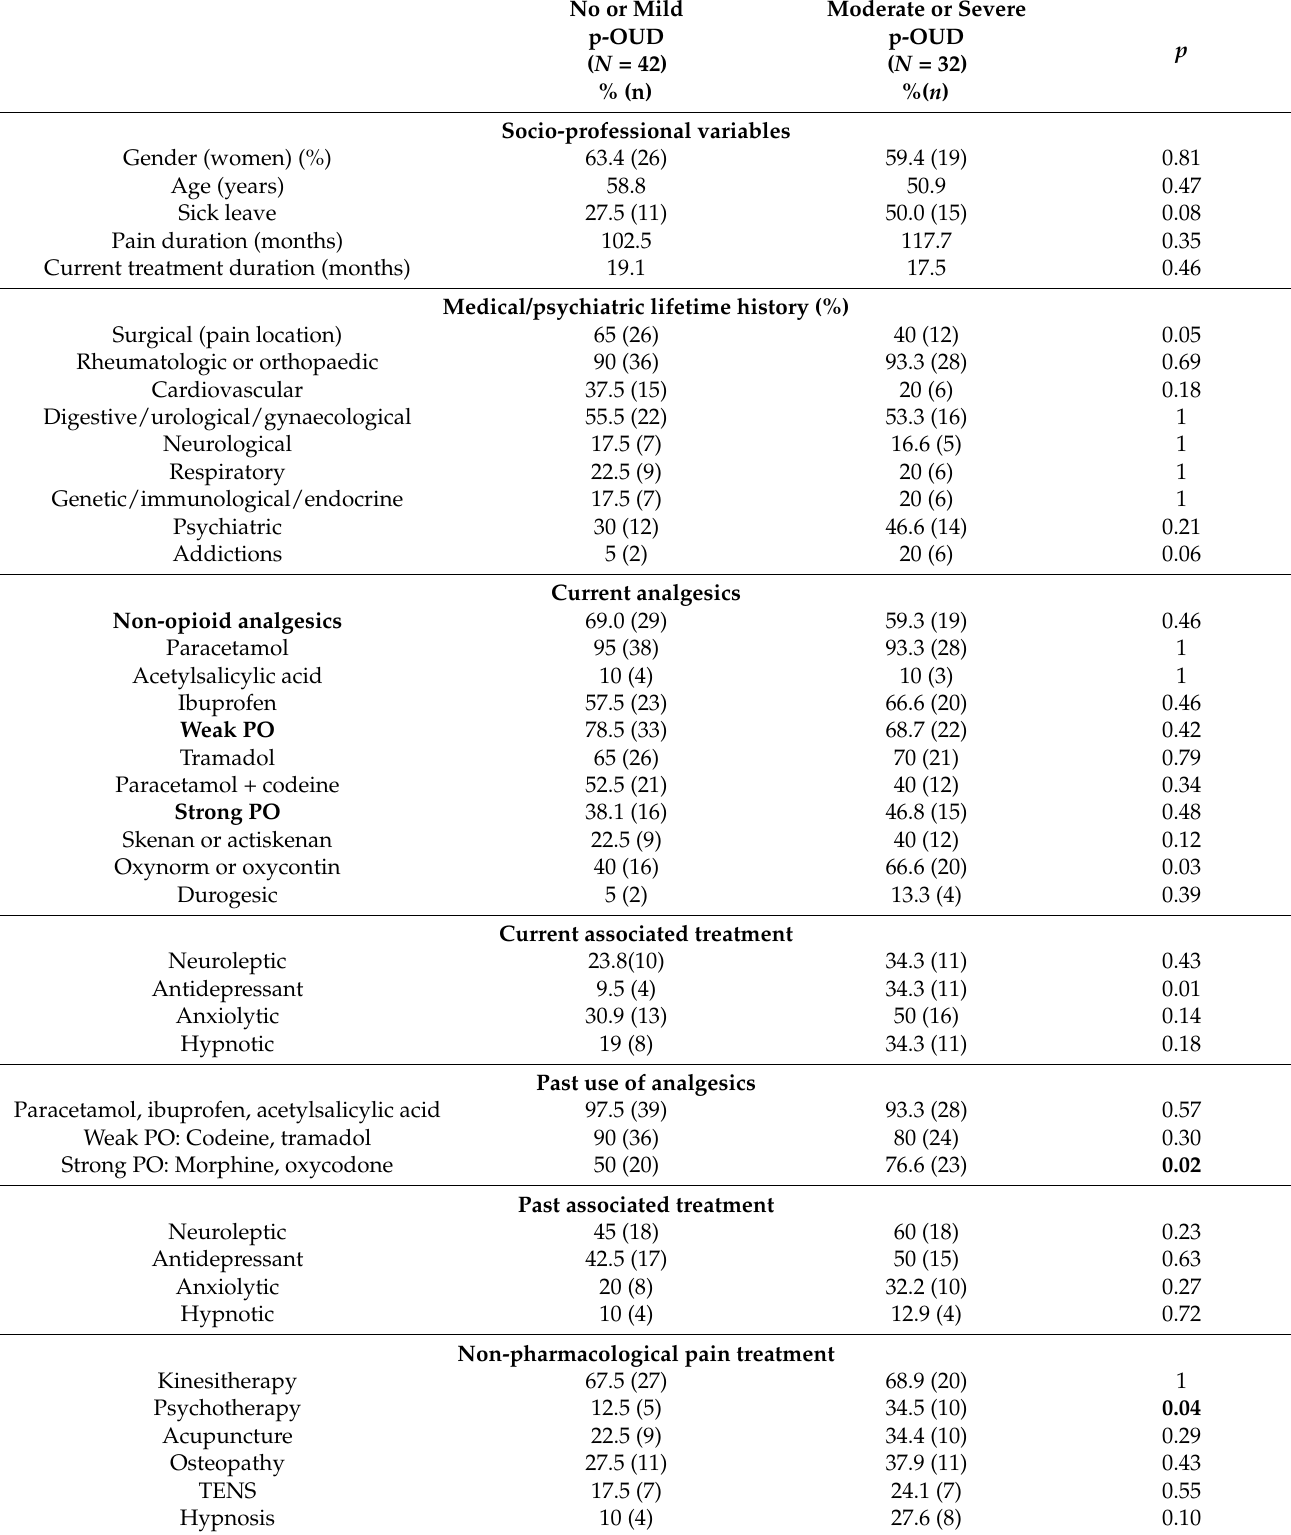
Table 4. A comparison of patients with moderate or severe prescribed-opioid use disorder (p-OUD) vs. no or mild